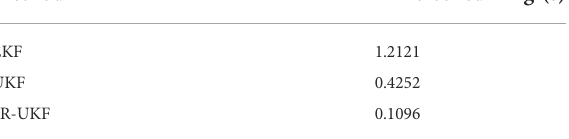
TABLE 5 Comparison results of computing ef fi ciency between different algorithms.